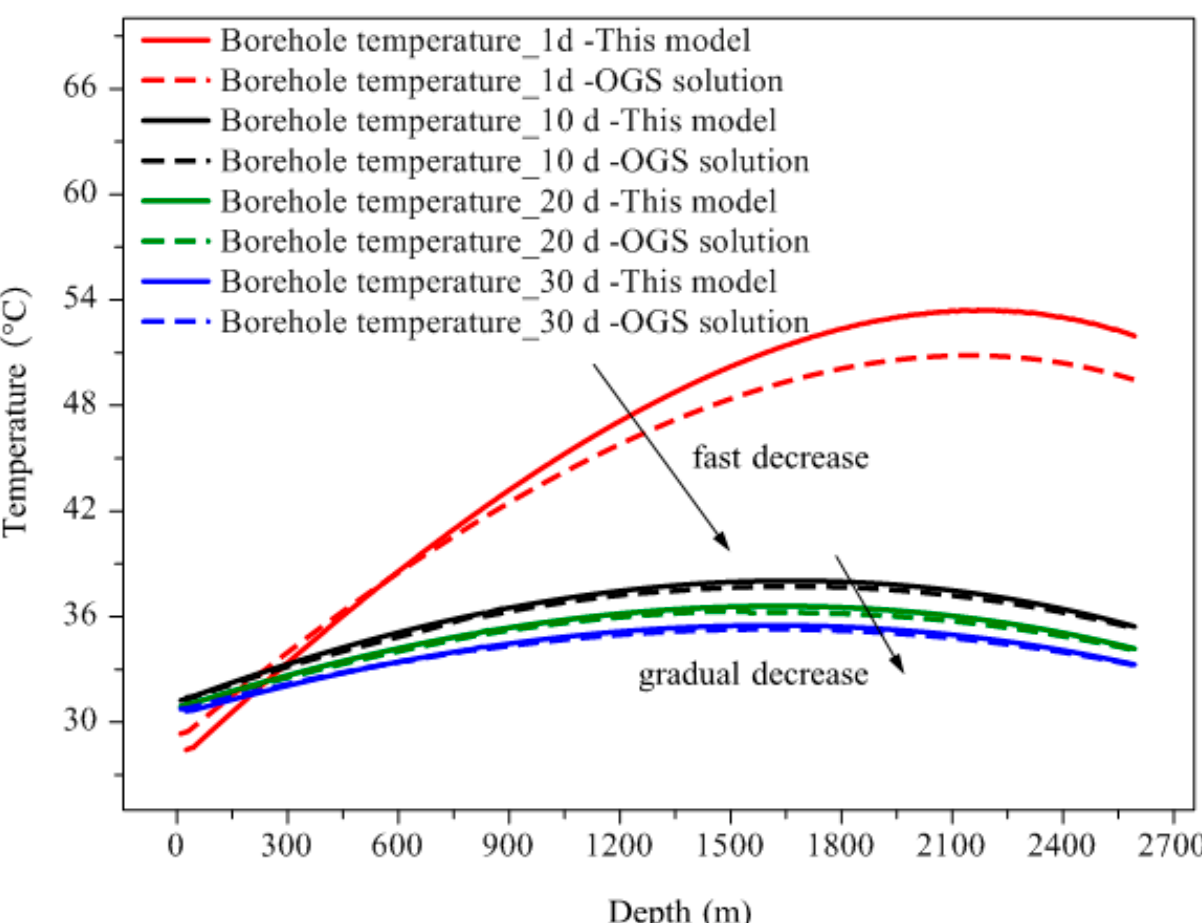
Figure 10. Distribution of borehole temperature along depth during the low temperature heat storage days.